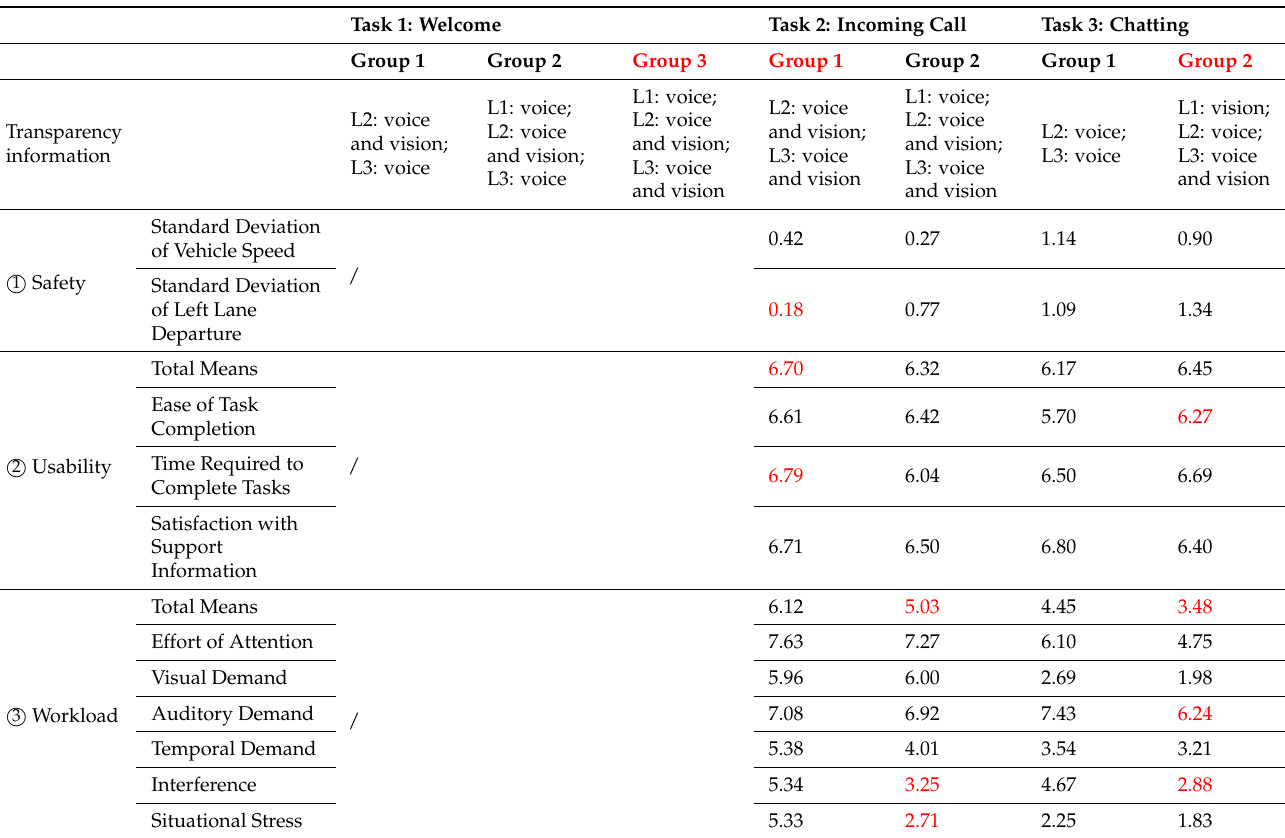
Table 1. Summary table of the experimental results. The red font marks the better data that has been statistically tested. The reasons for choosing a better group are explained at the end of the